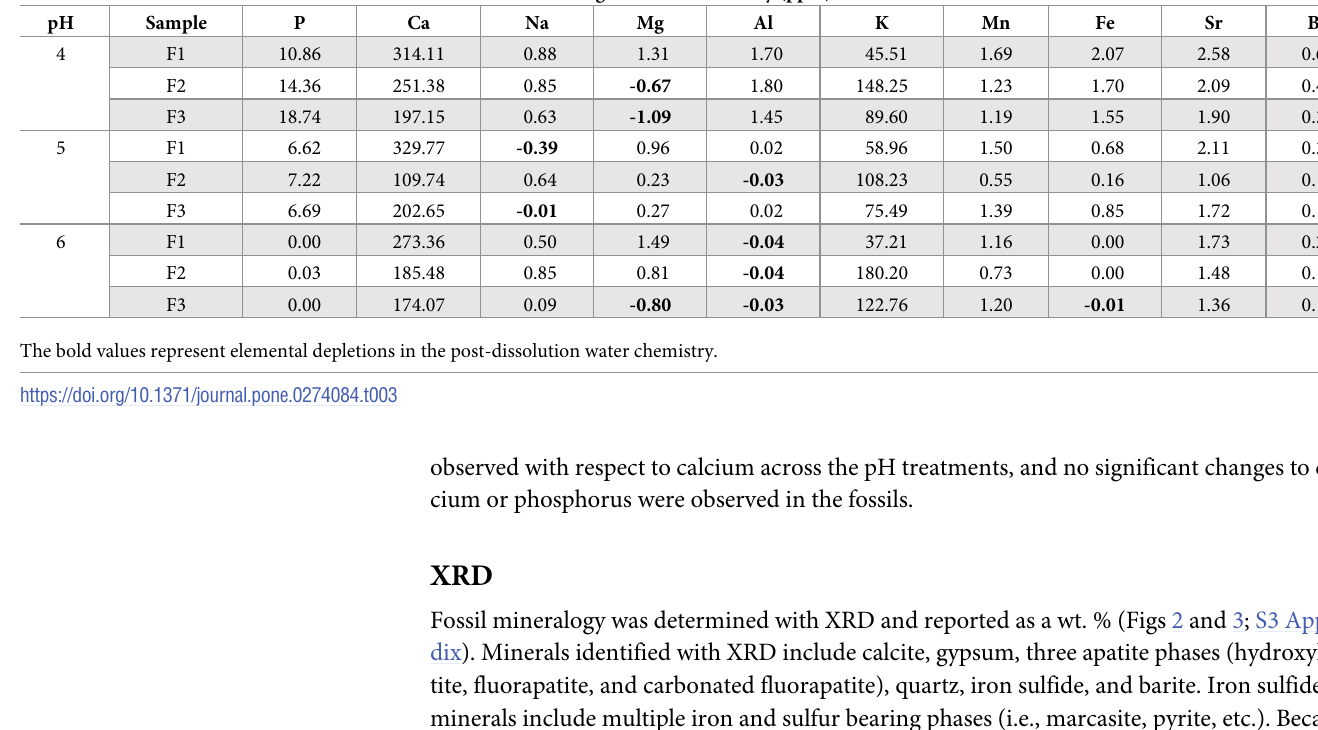
Table 3. Changes in water chemistry from pre- to post-dissolution samples.